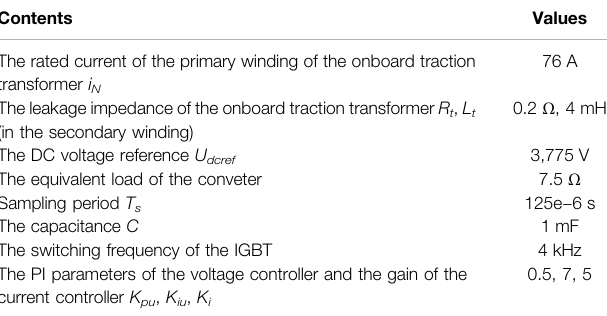
TABLE 3 | The simulation parameters of the